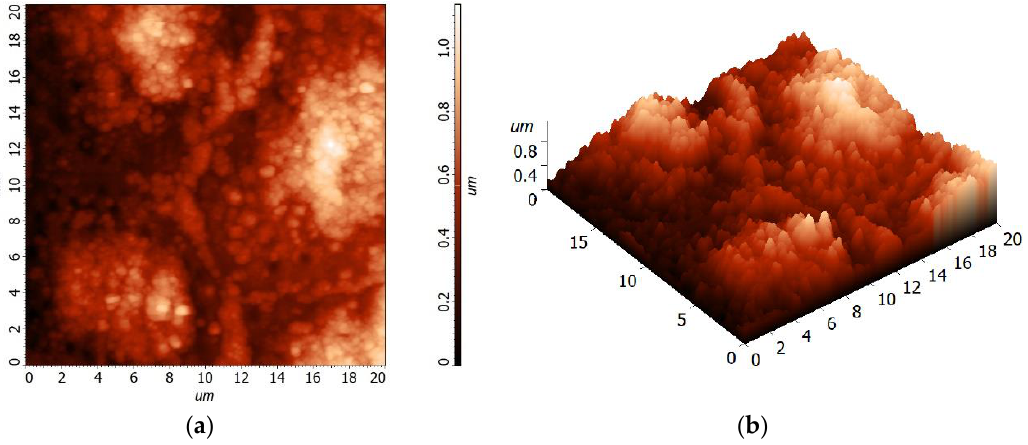
Figure 5. ( a ) 2D topography and ( b ) 3D topography of the “downgraded” ( x = 3-4-5) BST thin film